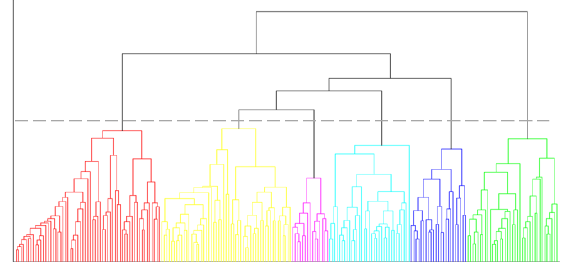
Fig. 7. Clustering results‟ interpretation with a dendrogram.